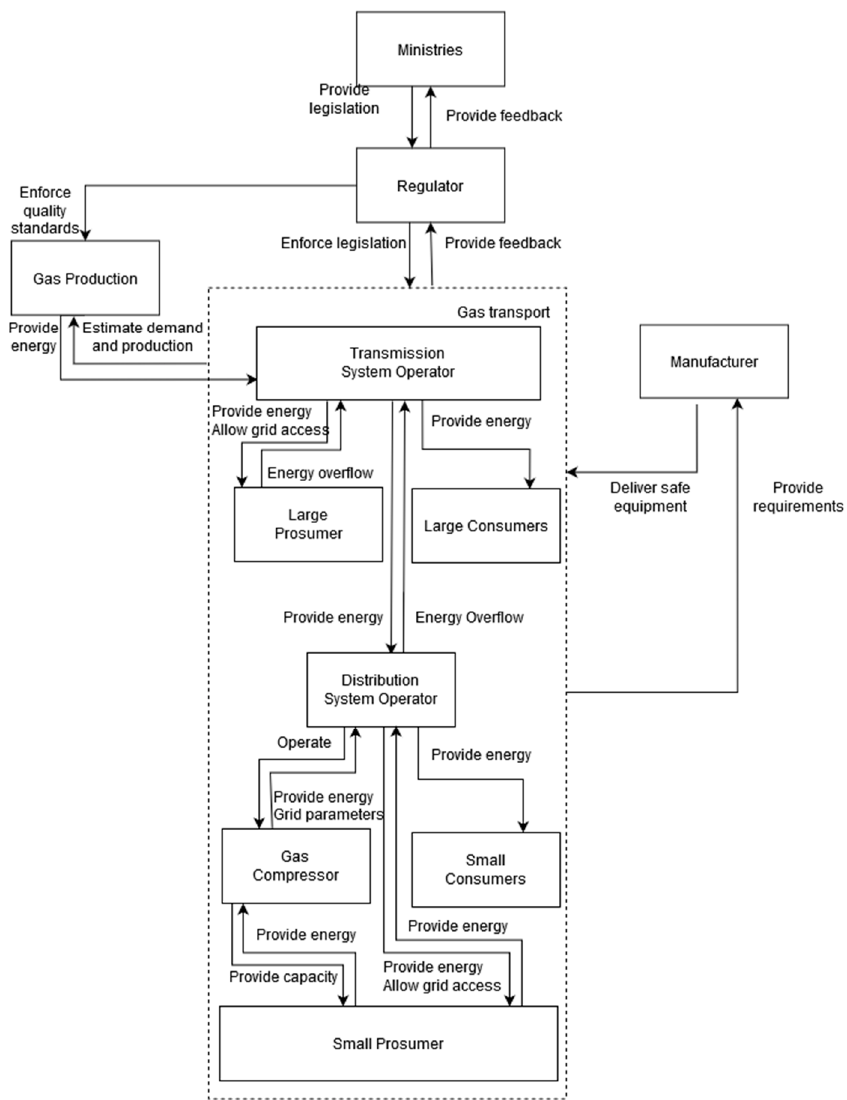
Figure A1. Control structure gas compressor.